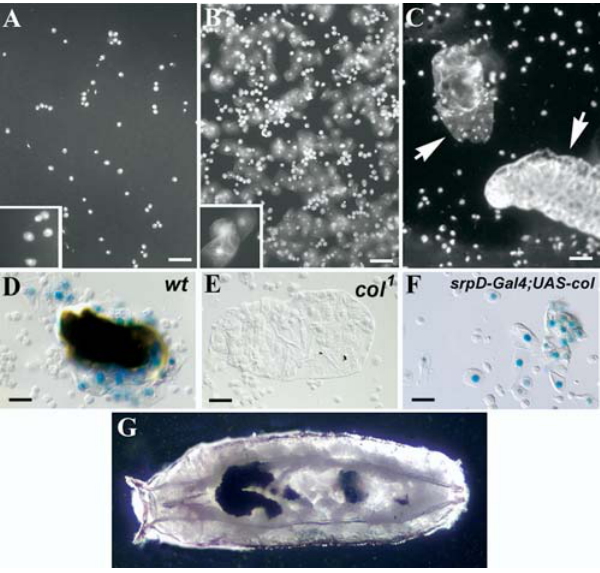
Figure 2. col Requirement for Lamellocyte Differentiation (A–C) 4 9 ,6-diamidino-2-phenylindole (DAPI) staining of hemocytes from wt (A and B) and from col 1 (C) third instar larvae. (A) Uninfected larva; (B) and (C) infected larvae. Plasmatocytes (inset in [A]) are always present, whereas lamellocytes (inset in [B]) are detected in the hemolymph of wt (B) but not col 1 (C) larvae 48 h after infestation by L. boulardi. In col 1 mutants, the wasp eggs are not encapsulated (white arrows) and develop into larvae (bottom right organism in [C]). (D–F) Lamellocytes expressing the P- lacZ marker l(3)06949 (Braun et al. 1997) surround the wasp eggs in wt larvae (D), are completely absent in infected col 1 mutant larvae (E), and differentiate in the absence of wasp infection following enforced Col expression in hematopoietic cells ( srpD-Gal4/UAS-col larvae) (F). (G) srpD-Gal4/UAS- col pupa showing the presence of melanotic tumors. Bars: 50 l